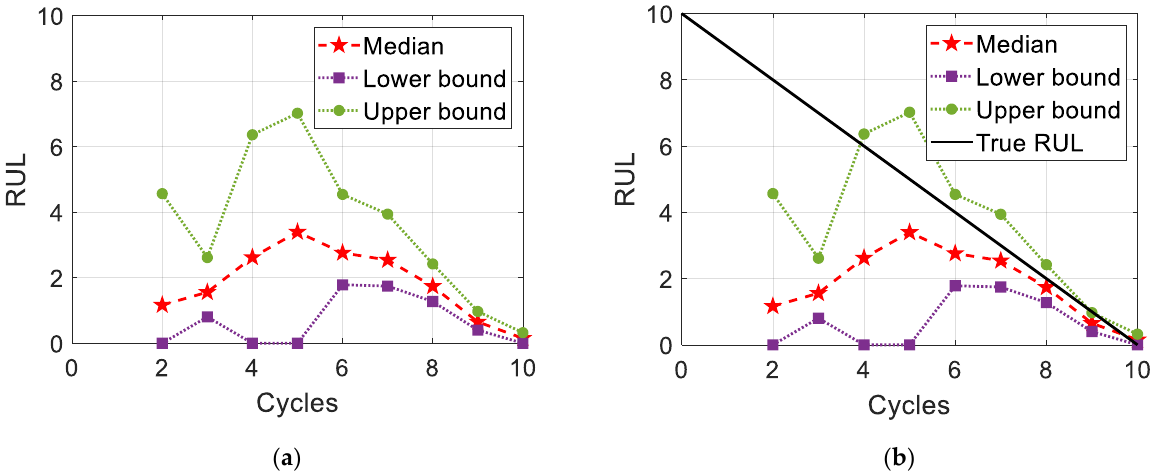
Figure 1. Illustration of RUL prediction results. ( a ) RUL prediction results, ( b ) RUL prediction results with true RUL.